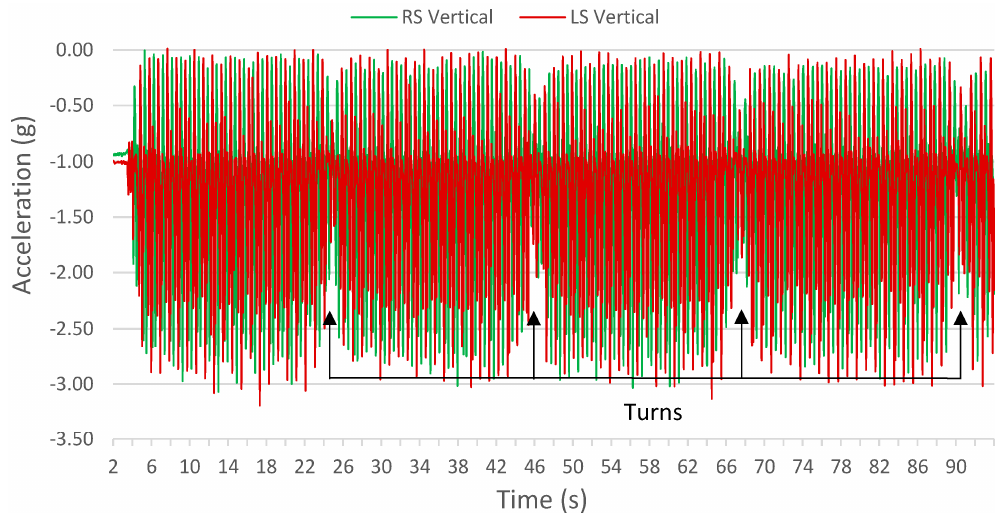
Figure 2. Section of left and right vertical accelerometer signals. Periodic drops in vertical acceleration magnitude locate turns in the 6MWT.